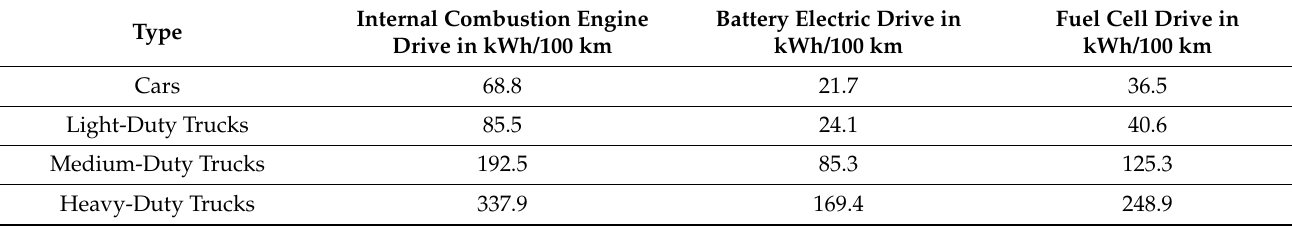
Table A14. Energy consumption of cars and trucks in the scenario Sufficiency (calculated values based on